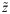
Negative equilibrium cost.(B) Cost of signalling L depending on offspring condition c and amount of transferred resource z (Eq 18). Red-green curve along the surface (and in inset) indicates equilibrium cost function (f(x*(c))) at equilibrium z˜ (Eq 19), where red sections indicate negative cost values. (A) shows this curve projected to the c-f(c) plane. Parameters are: {Z=4,G=0.1,U=1,γ=12,ψ=12,cmax=5,α=5}.